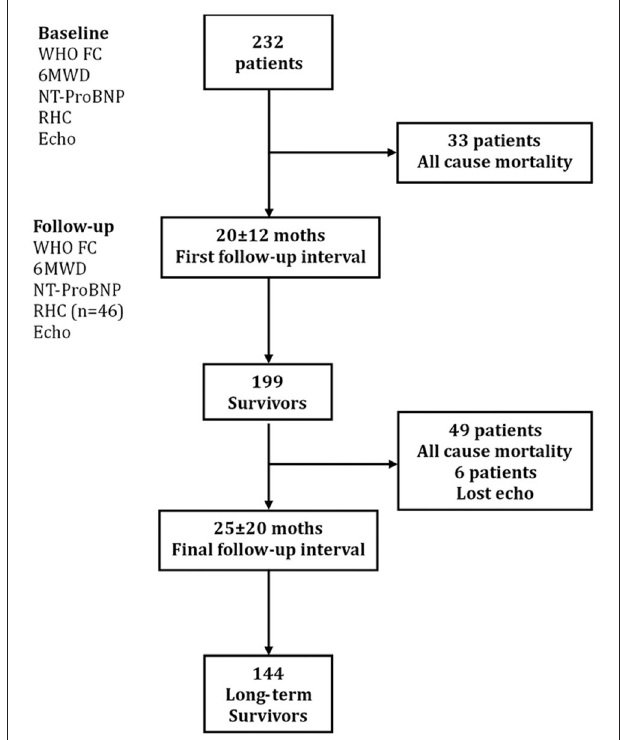
FIGURE 1 | Study design flowchart. Echo, echocardiography; 6MWD, 6-min walking distance; NT-proBNP, N-terminal fragmental of pro–brain natriuretic peptide; RHC, right heart catheterization; WHO FC, World Health Organization functional